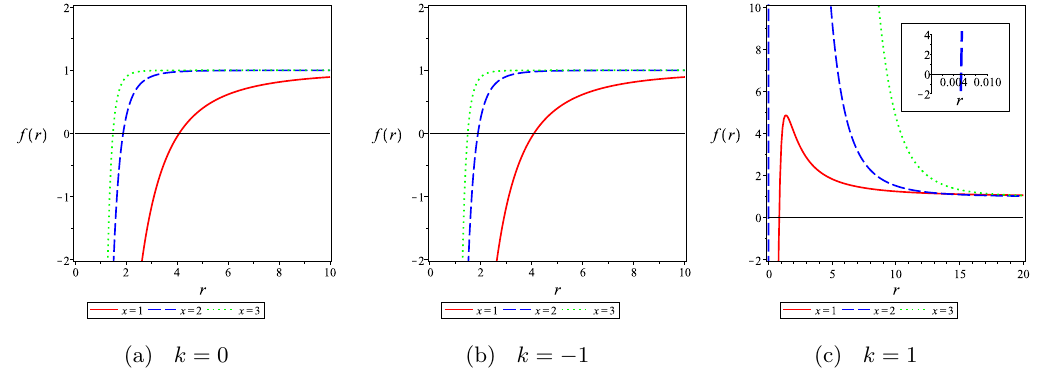
Figure 2 . Behavior of f ( r ) versus r for n = 5 , G = 1 , α = 3 and M = 5 for “ − ” sign